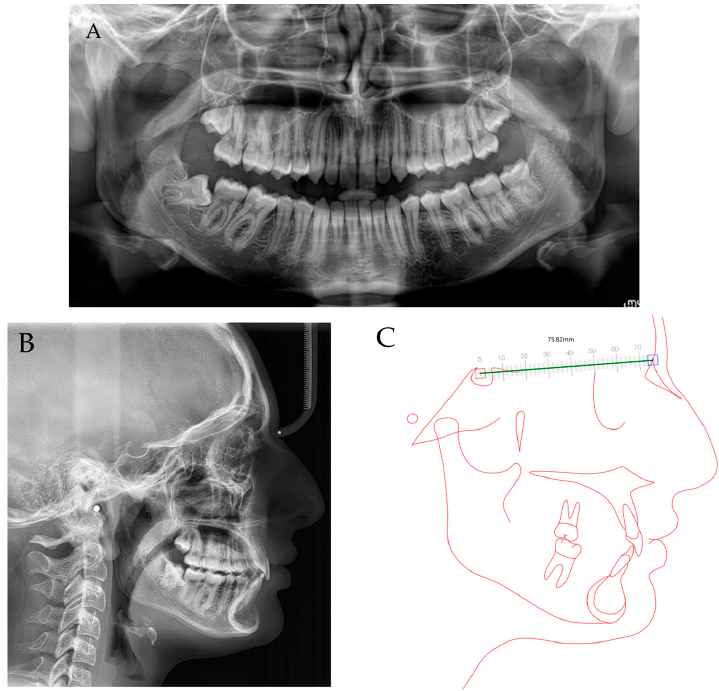
Figure 14. Final panoramic X-ray ( A ), teleradiograph ( B ) and cephalometry ( C ). At post-treatment cephalometric analysis, the skeletal Class in ANB reduced from 3° to − 0.9° (norm = 3 ± 2°), due to the point “A” being more retruded, considering the upper incisor retrusion with lingual root torque. This also explains the reduced values for alveolar maxilo-mandibular relation (A-B distance) from 6.9 to 1.5, norm = 5 ± 1°). The high upper incisor’s pro-inclination was normalized (UI/NA= 43° to 23.6°, norm = 22 ± 2°), but the lower incisor’s pro-inclination was worsened (IMPA = 96° to 105.7°, norm = 90 ± 3°), inherent to the overjet correction with compensation. The severe hypodivergent biotype was improved (FMA = 19° to 15.5°, norm = 25 ± 3°).